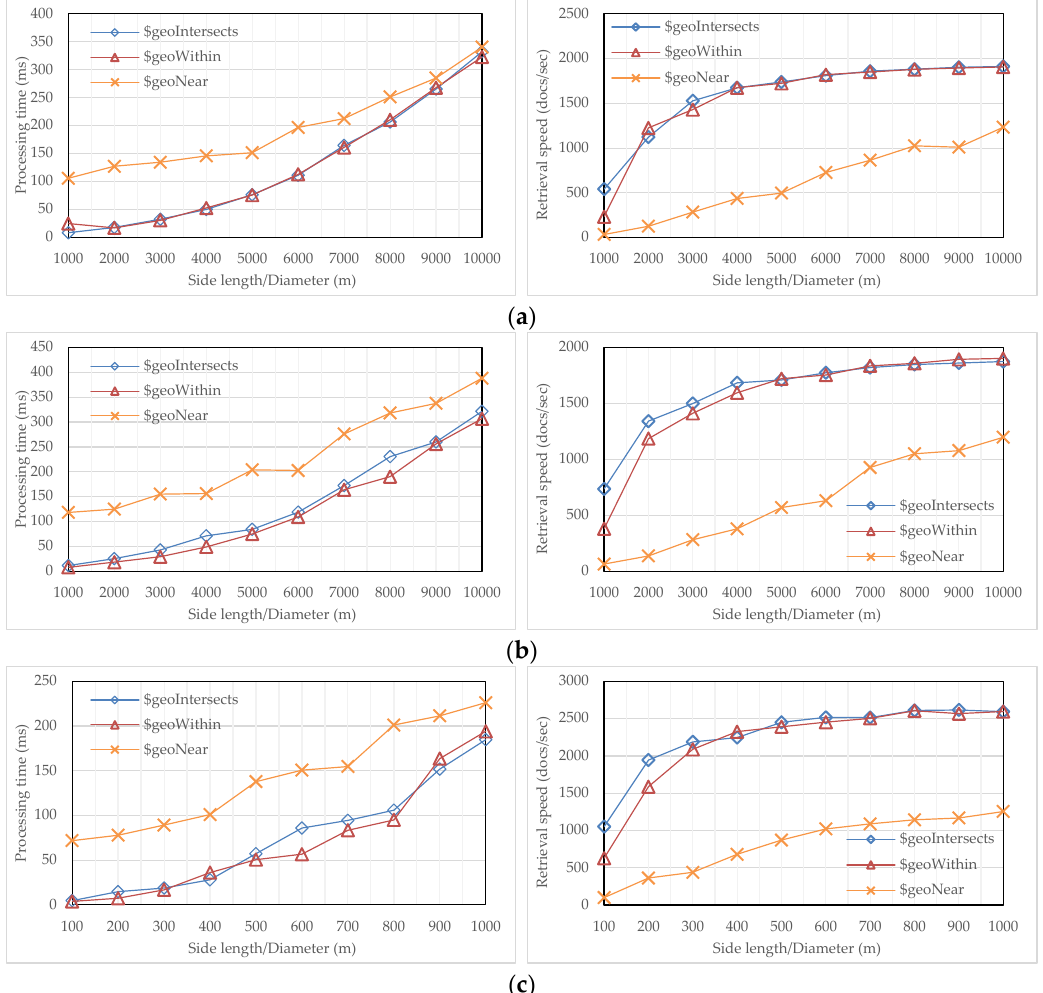
Figure 11. Query processing evaluation with different datasets. ( a ) Paris POI data; ( b ) Beijing street data; and ( c ) Washington DC building data.